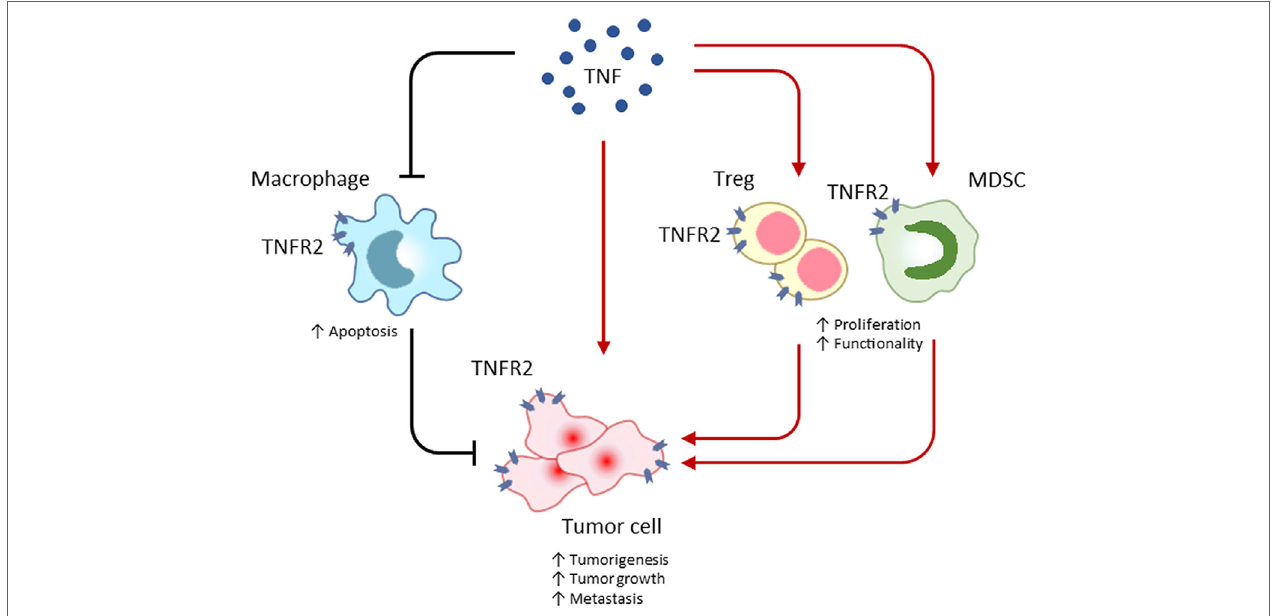
FiGURe 1 | TNF receptor 2 (TNFR2) promotes tumor progression by maintaining a tumor-favoring immune-microenvironment or by facilitating malignant cell proliferation and survival. In the tumor microenvironment, TNFR2 is extensively expressed on many types of cells, including immune cells and malignant cells. TNFR2 often accelerates the malignant transformation and growth of tumor cells, instead of inducing cell death by apoptosis. Similar to tumor cells, TNFR2 protects immunosuppressive regulatory T (T reg ) cells and myeloid-derived suppressor cells (MDSC) from the death-inducing TNF and consequently enhances proliferation and function of those tumor-promoting cells. Even worse, TNFR2 deteriorates the programmed death of phagocytic macrophages responsible for clearing of tumor cells. Mediating those direct and indirect effects, TNFR2 exacerbates cancer